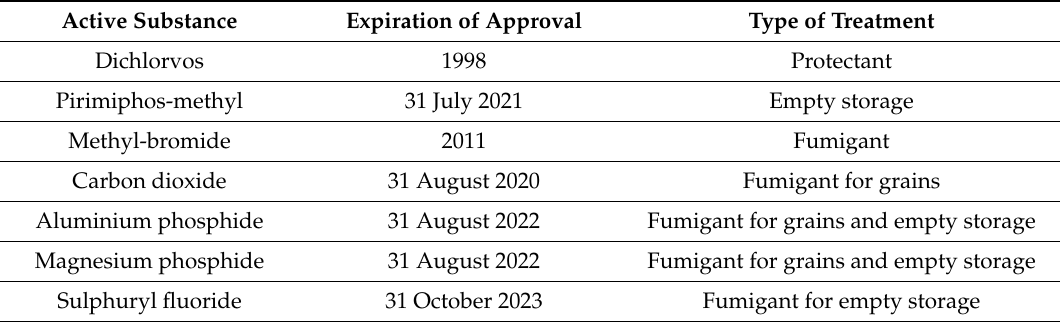
Table 1. Active substances and dates of expiration of approval and type of treatment